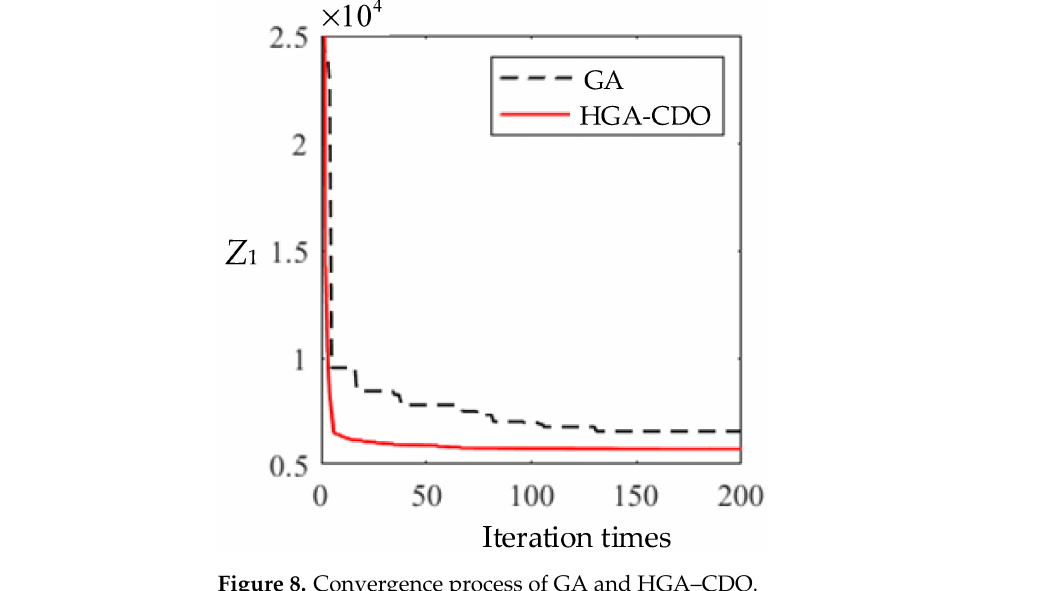
Figure 8. Convergence process of GA and HGA–CDO. Table 2. Algorithm